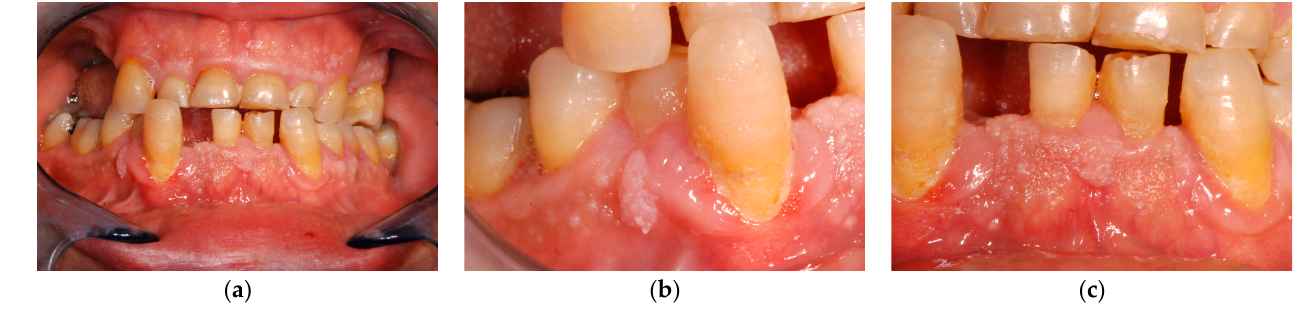
Figure 4. Patient 3, clinical lesions. ( a ) Overall view. ( b , c ) Gingival lumps